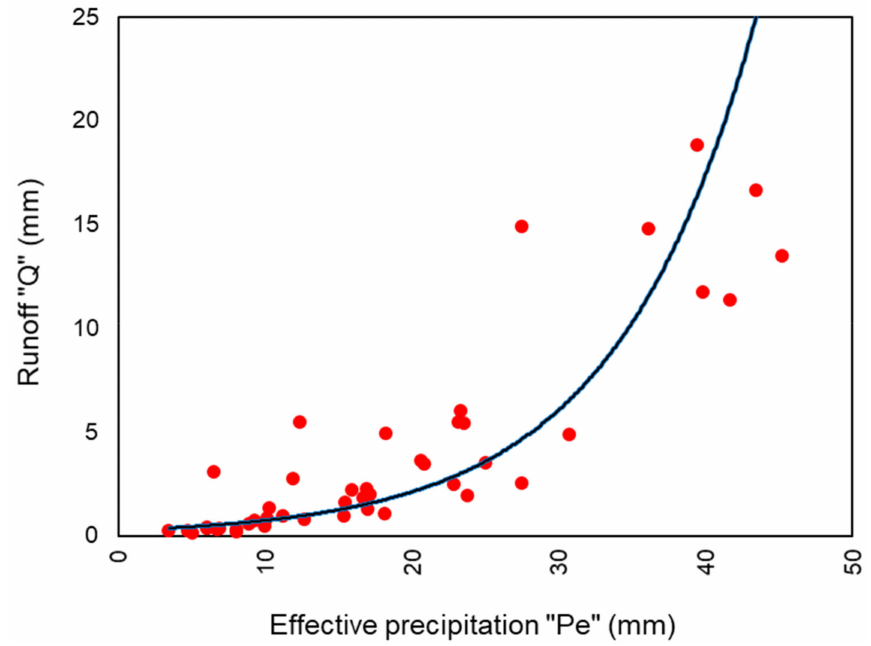
Figure 3. Distributed CN-VSA method step 1: A line graph between runoff amount (Q) and effective precipitation (P e ) to compute S (potential maximum